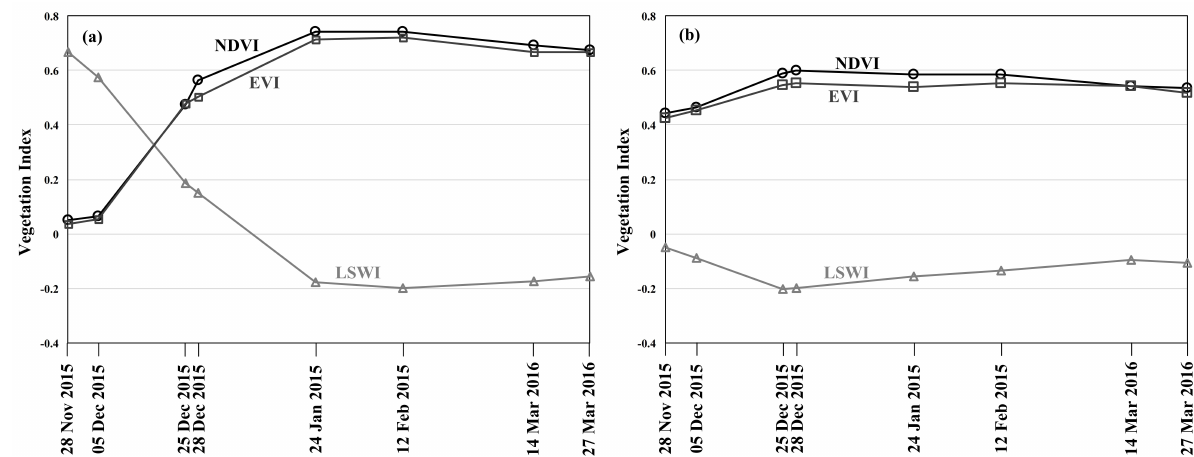
Figure 5. Temporal variations of Land Surface Water Index (LSWI), Normalized Difference Vegetation Index (NDVI), and Enhanced Vegetation Index (EVI) for (a) rice and (b) non-rice (citrus)